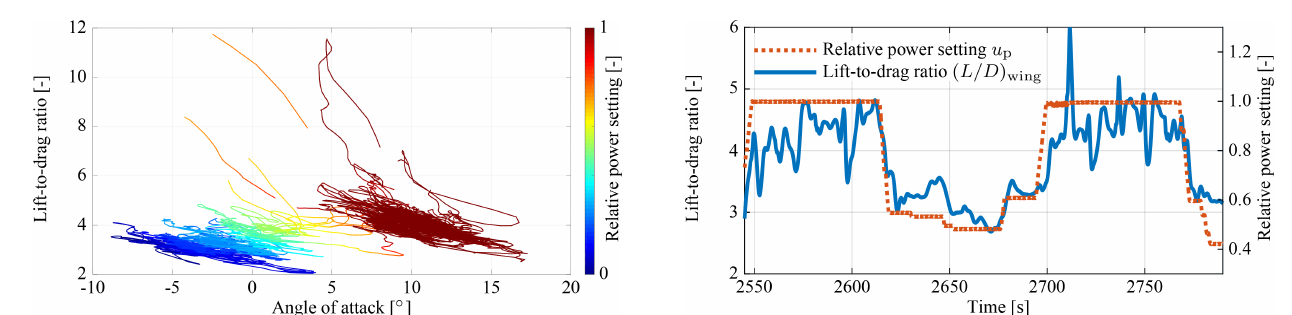
Figure 14. Measured lift-to-drag ratio L/D of the kite plotted over the angle of attack α and colored by the relative power setting u p . The coloring ranges from blue, for lower values of u p when retract- ing the kite, up to dark red, for the fully powered kite with u p = 1 during the traction phase. Table 2 filters no. 1 and no. 2 have been applied.